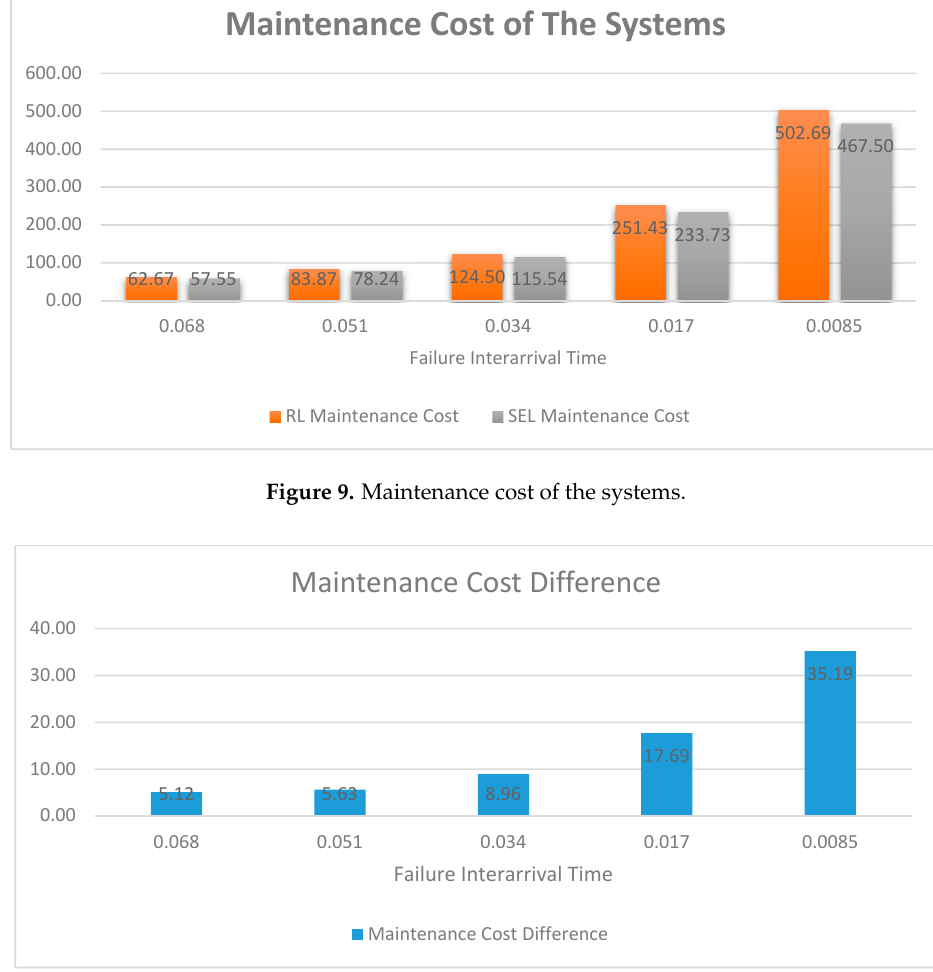
Figure 10. Maintenance cost differences between two systems.